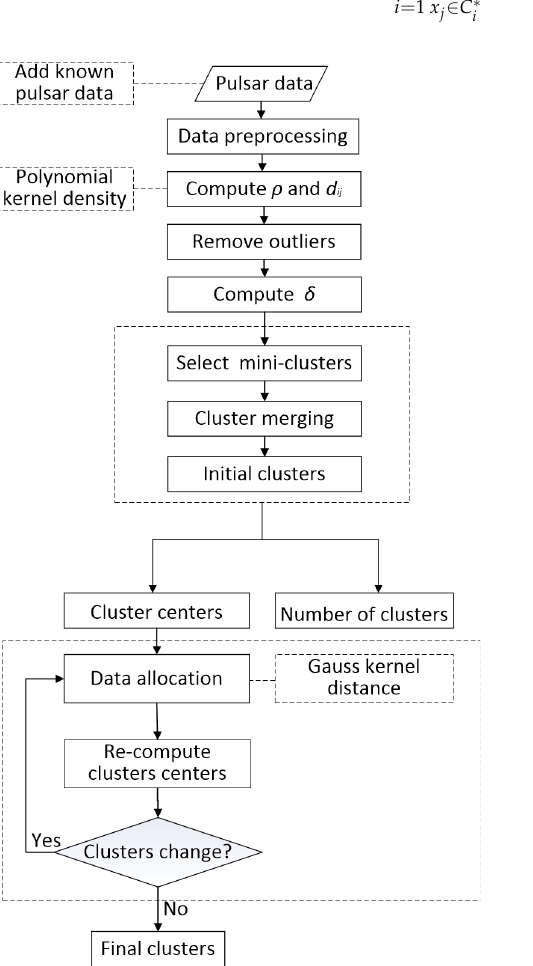
Figure 2. Flow chart of the hybrid clustering